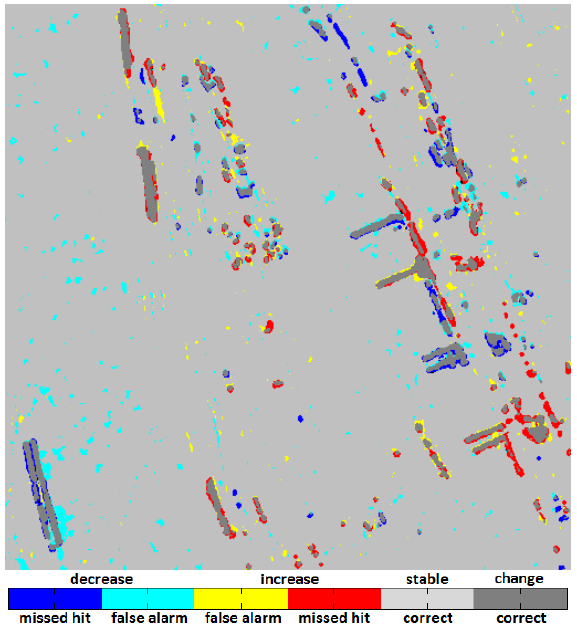
Figure 19. Location of the confusion matrix elements for the change in amplitude using pixel-based log-ratio with preceding GMAP speckle suppression.